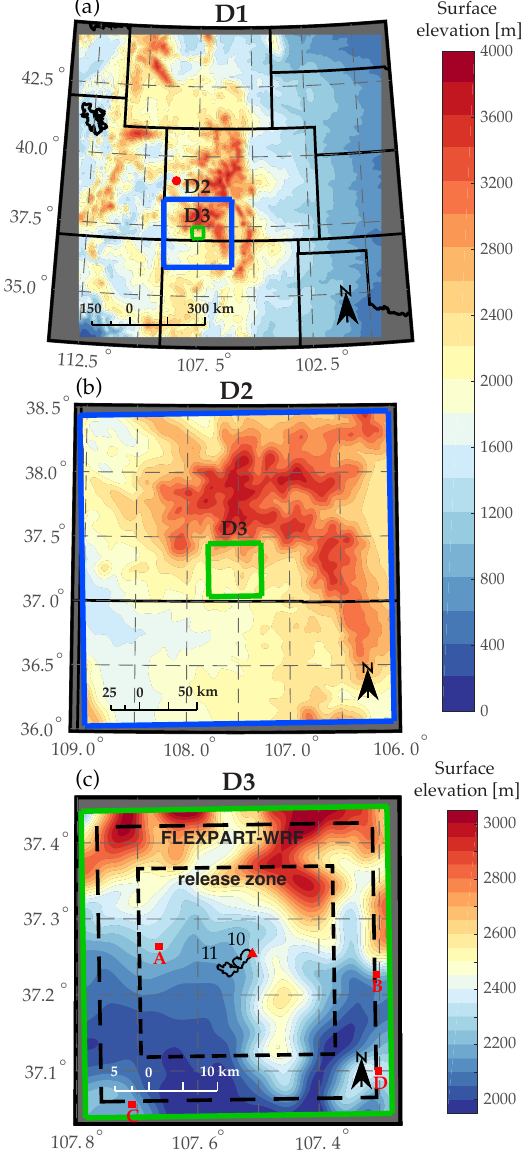
Figure 1. Plan view maps of surface elevation (m, above mean sea level) in Advanced Regional Prediction System (ARPS) domains ( a ) D1, ( b ) D2, and ( c ) D3. In ( c ), the FLEXPART-WRF domain and particle release zone described in Section 2.3 are indicated with long and short dash black squares, respectively. In ( a , c ), red symbols indicate observation sites: circle Grand Junction, Colorado (KGJT) rawinsonde, triangle (Saul’s Creek portable rawinsonde and light detection and ranging (LiDAR) ceilometer, co-located), square (Remote Automated Weather Stations (RAWS); letters correspond to panels in Figure 5). The black polygons in the center of ( c ) depict the two burn units active on 10 September 2018, units 10 and